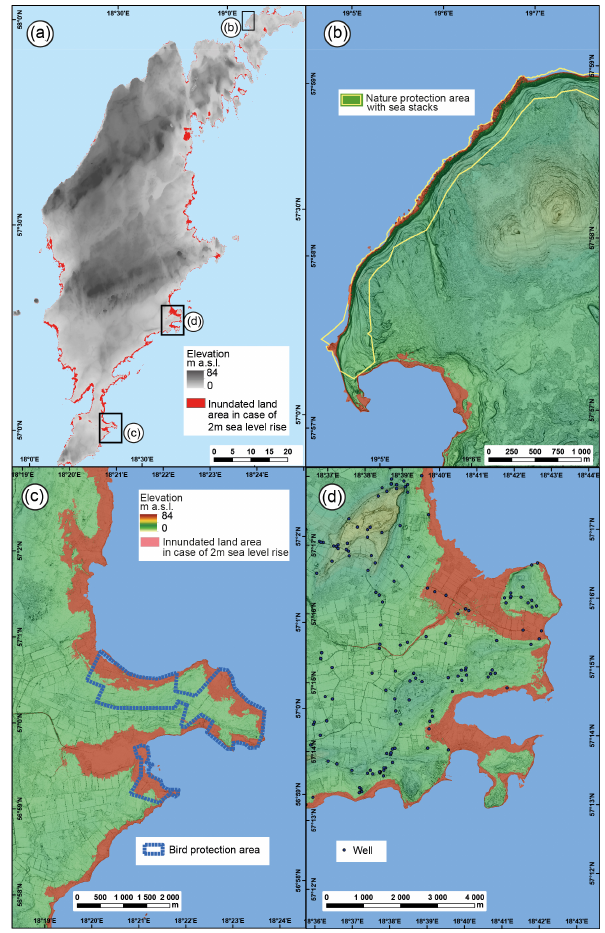
Figure 2. (a) In the case of a 2m sea level rise, 99km 2 of Gotland’s total area of 3140km 2 will be inundated, corresponding to 3% of Gotland’s land area. (b) Gotland is famous for its nature attractions, e.g. the sea stack area in Digerhuvud’s nature reservoir, NW Got- land. (c) Gotland has the richest bird life in northern Europe. A number of bird protection areas, mostly located at the coast, will be inundated. (d) In some areas, the sea will intrude more than 1km inland in case of a 2m sea level rise. Except for natural and cul- tural features, agricultural areas and wells will be affected. In some cases, new islands will be created.